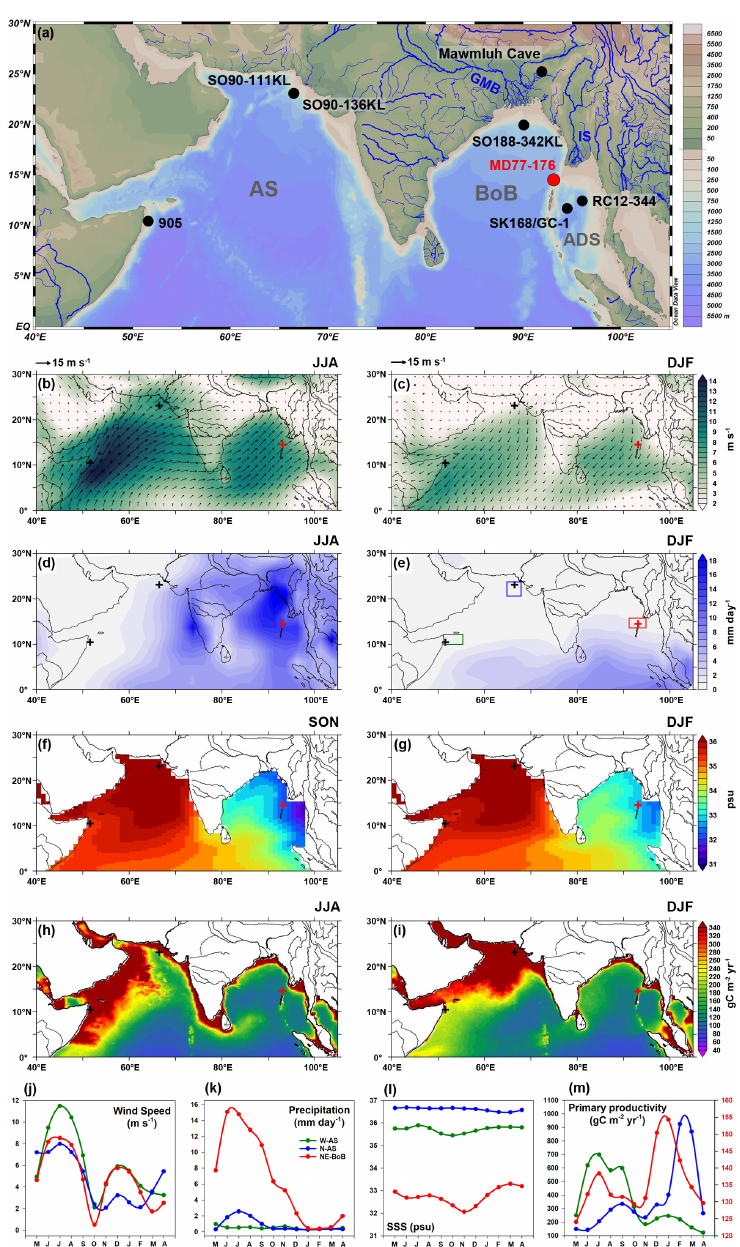
Figure 1. (a) Geographic setting and bathymetric map of the Indian monsoon climate zone including the Arabian Sea (AS), the Bay of Bengal (BoB), the Andaman Sea (ADS), the Ganges–Brahmaputra–Meghna river system (GMB), and the Irrawaddy–Salween river sys- tem (IS). The map was created with Ocean Data View software (© Reiner Schlitzer, Alfred Wegener Institute) with its built-in global high-resolution bathymetric data (GlobHR). The location of the sediment core MD77-176 is marked by the red circle. Black circles mark the locations of published records shown in Fig. 6. (b, c) Mean (from 1979 to 2018) surface wind speed and wind vectors for Northern Hemisphere (NH) summer (June–July–August, JJA) and winter (December–January–February, DJF), respectively. Data are from NCEP-DOE Reanalysis 2 (https://psl.noaa.gov/data/gridded/data.ncep.reanalysis2.html, last access: 25 October 2020). (d, e) Mean (from 1979 to 2018) precipitation rate for NH winter and summer, respectively. Data are from the CPC Merged Analysis of Precipitation (https://psl.noaa.gov/data/gridded/data.cmap.html, last access: 25 October 2020). (f, g) Mean (from 1979 to 2018) surface seawater salinity (SSS) for NH autumn (September–October–November, SON) and winter, respectively. Data are from the NCEP Global Ocean Data Assimi- lation System (https://psl.noaa.gov/data/gridded/data.godas.html, last access: 25 October 2020). (h, i) Mean (from 2003 to 2018) net primary productivity for NH summer and winter, respectively. PP data are based on MODIS chlorophyll a and calculated using the Vertical General- ized Production Model (VGPM; Behrenfeld and Falkowski, 1997) (http://science.oregonstate.edu/ocean.productivity, last access: 25 October 2020). (j–m) Regional climatology and oceanography in the western AS, northern AS, and northeastern BoB. The regions of data extraction are marked by coloured rectangles in panel (e) . Data sources are the same as